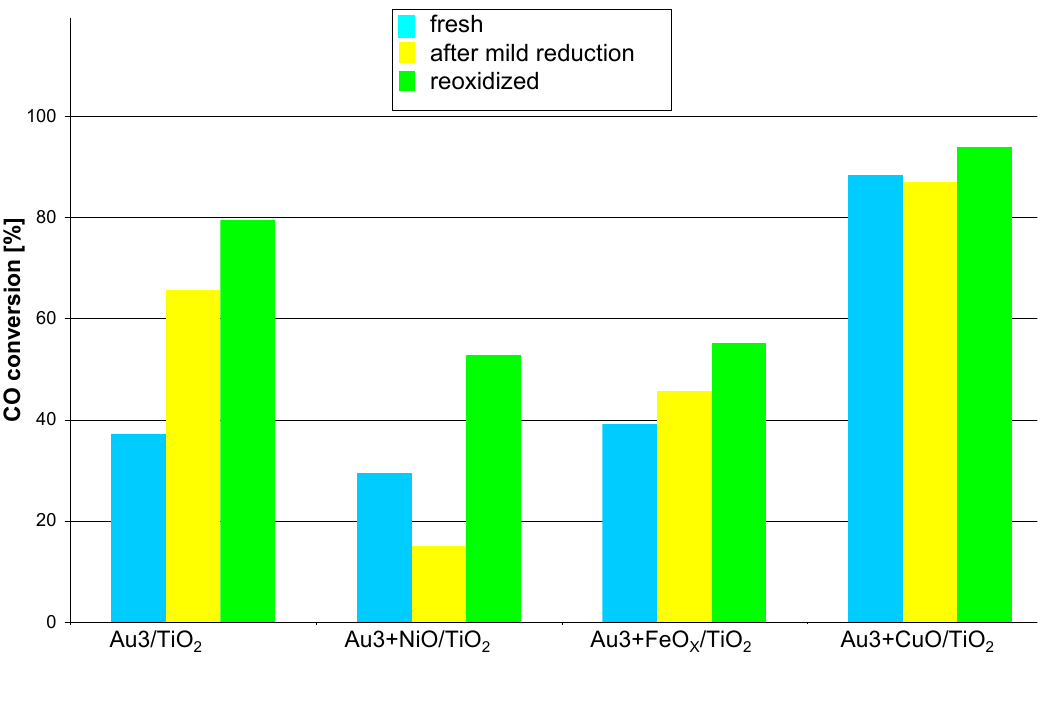
Figure 4. Catalytic activity at 35 °C measured for catalysts obtained by co-deposition of gold and base metal compounds (Ni, Fe, Cu) on TiO time: 0.36 s, feed composition: CO:O